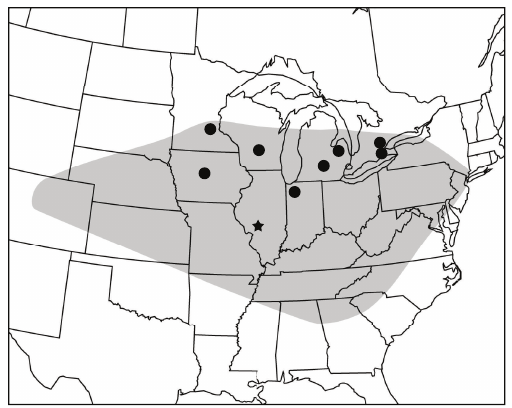
Figure 3: Map of Lasioglossum anomalum distribution in eastern North America with type locality indicated by a star. Circles indicate collection localities of DNA barcoded specimens. Modified from